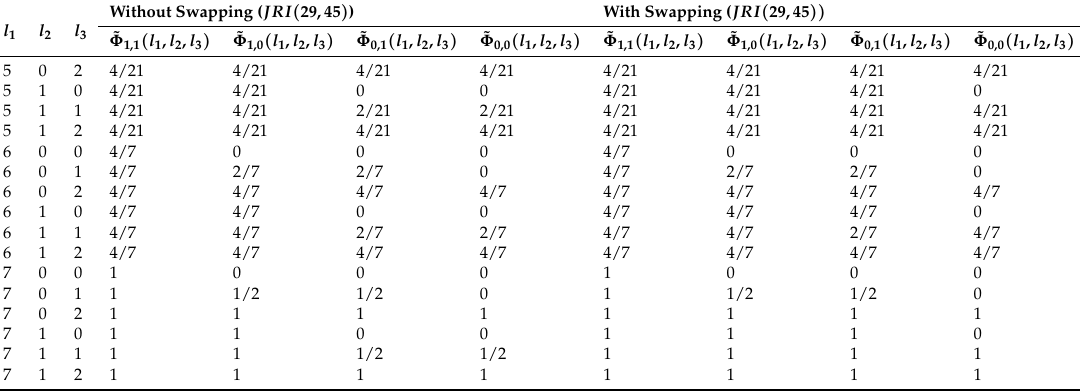
Table A5. Survival signatures of given states of components 29 and 45 (rows with ˜ Φ i , j = 0 are omitted).